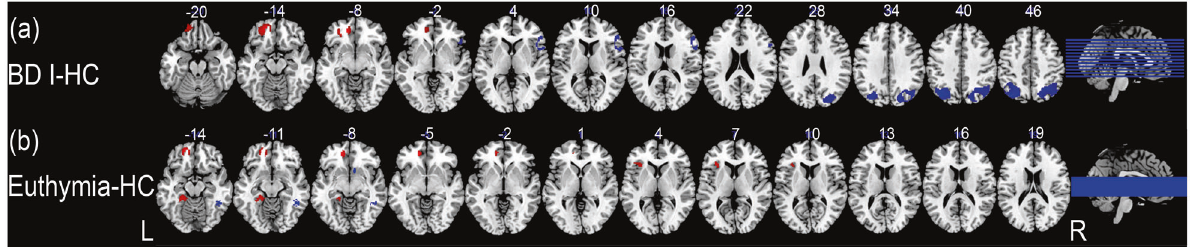
Fig. 3 Subgroup analyses of BD I and euthymic BD individuals. a Hyperactivation in left ACC and hypoactivation in the right angular gyrus, left middle occipital gyrus, and right inferior frontal gyrus were found in individuals with BD I relative to HC. b hyperactivation in the left OFC, left fusiform gyrus and insula, and hypoactivation in right temporal gyrus and striatum were found in individuals with euthymic BD relative to HC. Red and blue clusters represent hyperactivation and hypoactivation in individuals with BD compared to healthy controls, respectively. ACC anterior cingulate cortex, BD bipolar disorder, HC healthy controls, L left, OFC orbital frontal cortex, R